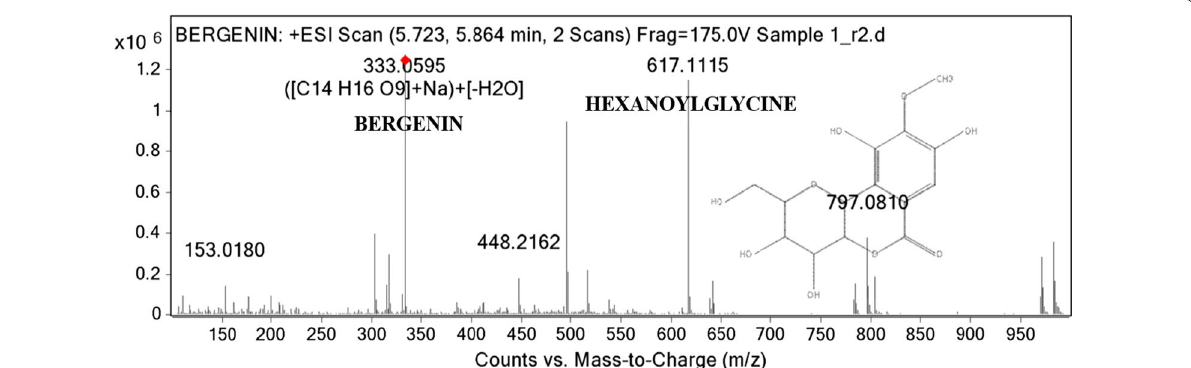
Fig. 1 HR LC–MS chromatogram of the plant extract fraction at 280 nm. Bergenin was present in the highest abundance. Lower abundance of the process